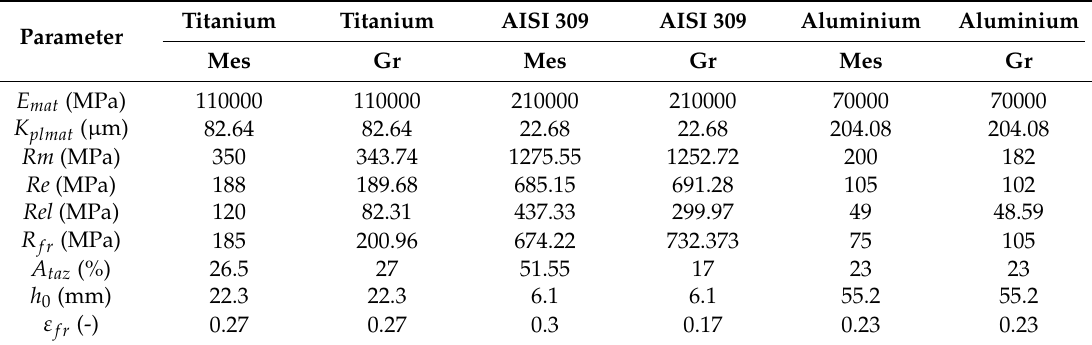
Table 2. Values obtained by tensile testing and values obtained by theoretical prediction calculations. Parameter